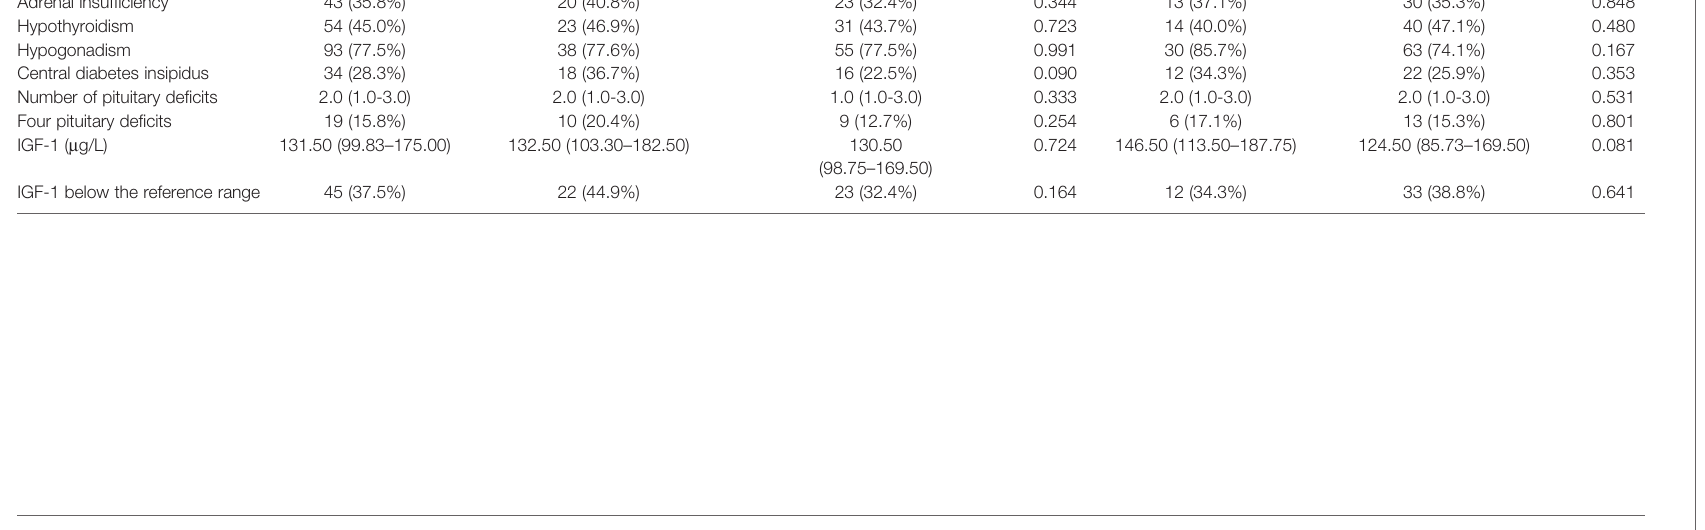
TABLE 3 | Postoperative pituitary